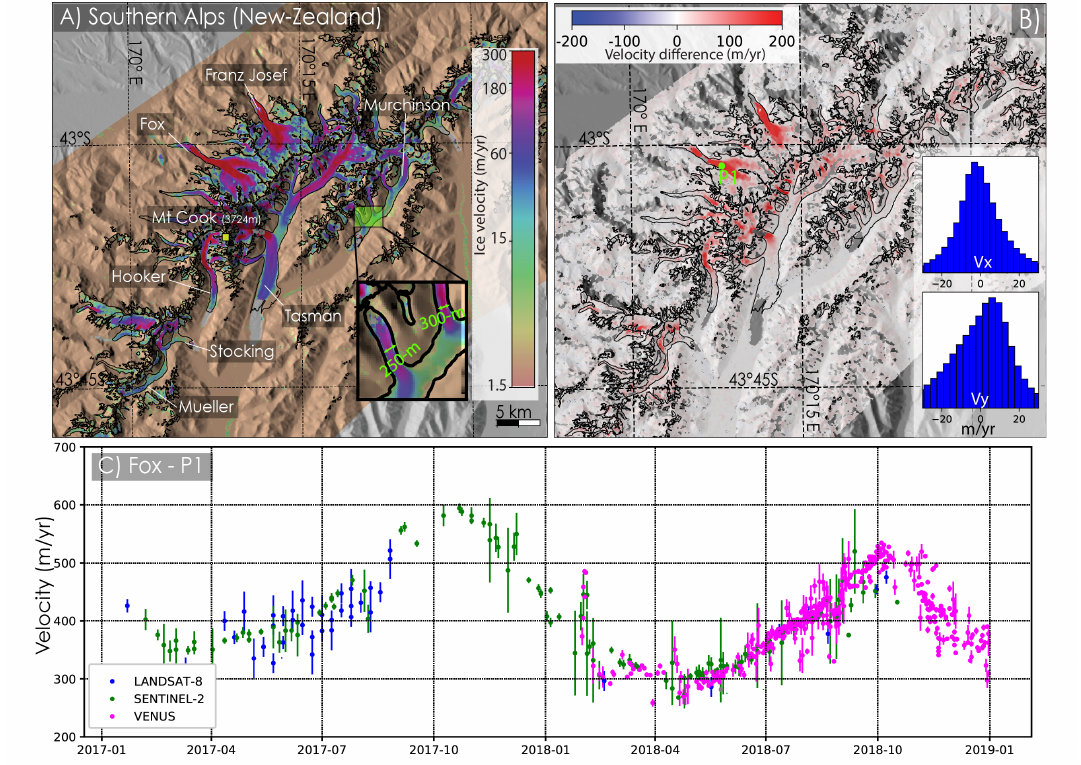
Figure 3. ( A ) Glacier surface velocity mosaic of the Tasman Glacier area in meters per year averaged over 2016–2018 quantified from Sentinel-2 images, colorbar is coded on a logarithmic scale going from brown (slow) to red (fast). Inset shows a zoom on two tributaries of Murchinson glacier; ( B ) Difference between March-July and October-December glacier surface velocities is color coded from blue to red. The inset graph shows the statistics and distribution of displacements on stable ground; ( C ) Time series of glacier surface velocity from Sentinel-2 (green), Landsat 8 (blue) and Ven µ s (pink) satellites between 2017 and 2018 of the upper part of Fox glacier indicated by a green dot labelled P1 in ( B